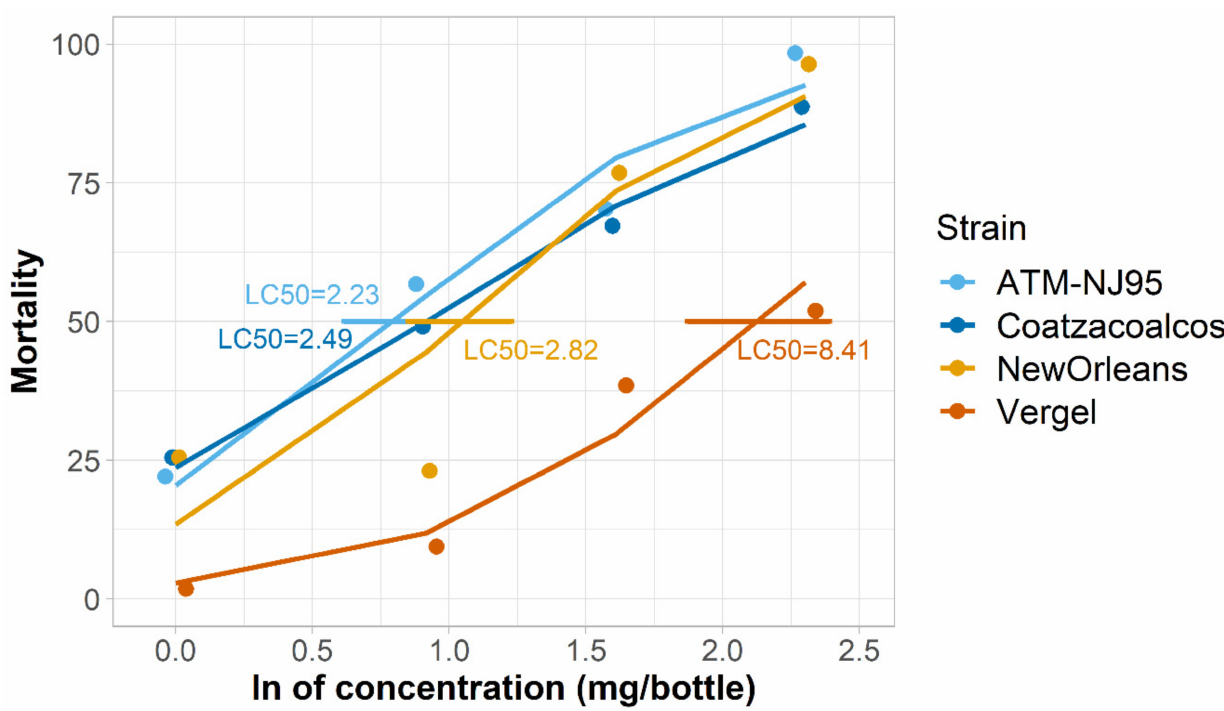
Figure 1. LC 50 and 95% confidence intervals of four Aedes spp. when exposed to nootkatone. Points show the mortality caused by each concentration. Concentration–response lines were adjusted to a binomial logistic regression model. The LC 50 for each strain is shown in mg/bottle.